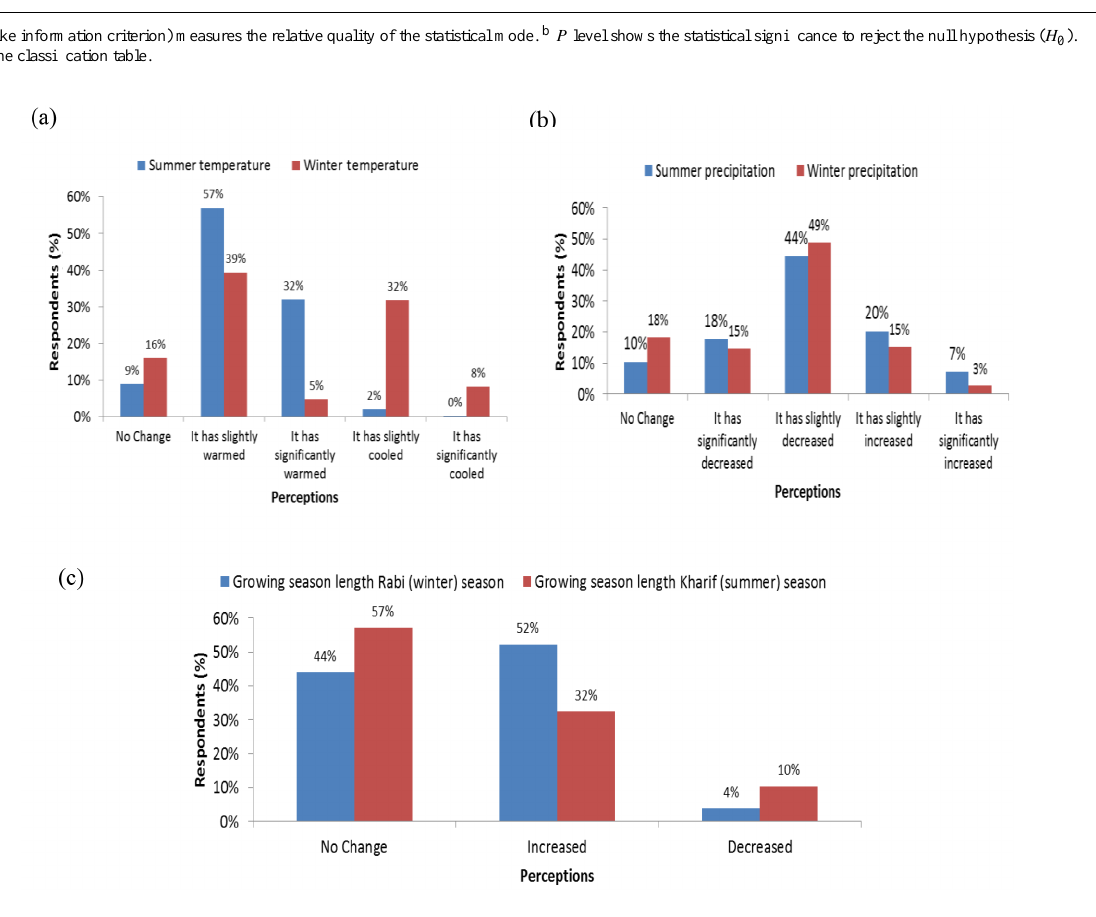
Figure 2. (a–c) Farmers’ perceptions of climate change in study area of Punjab province,